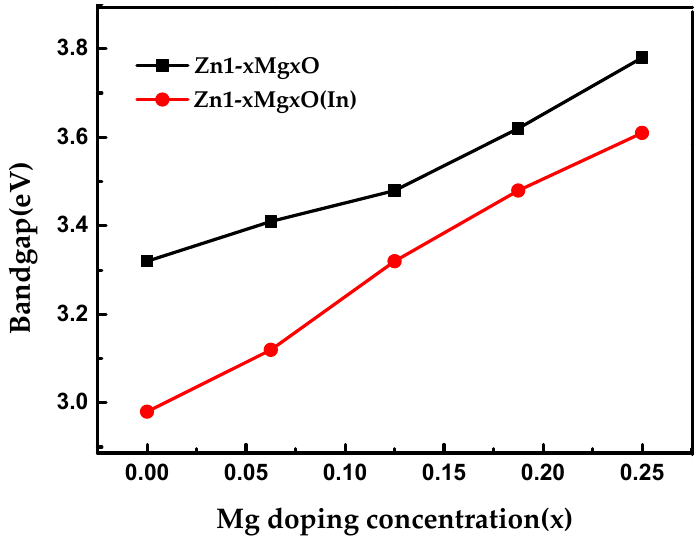
Figure 5. The band gap of Zn 1 − x Mg X O and Zn 1 − x Mg X O(In).